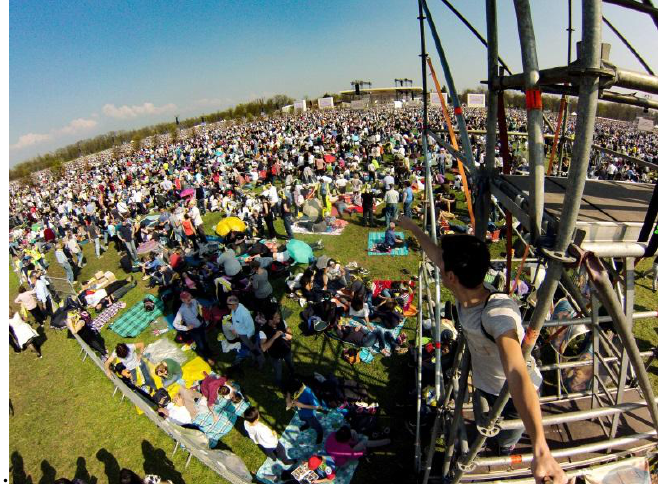
Figure 2. Solemn celebration of Pope Francis at Monza Park, picture from Instagram.